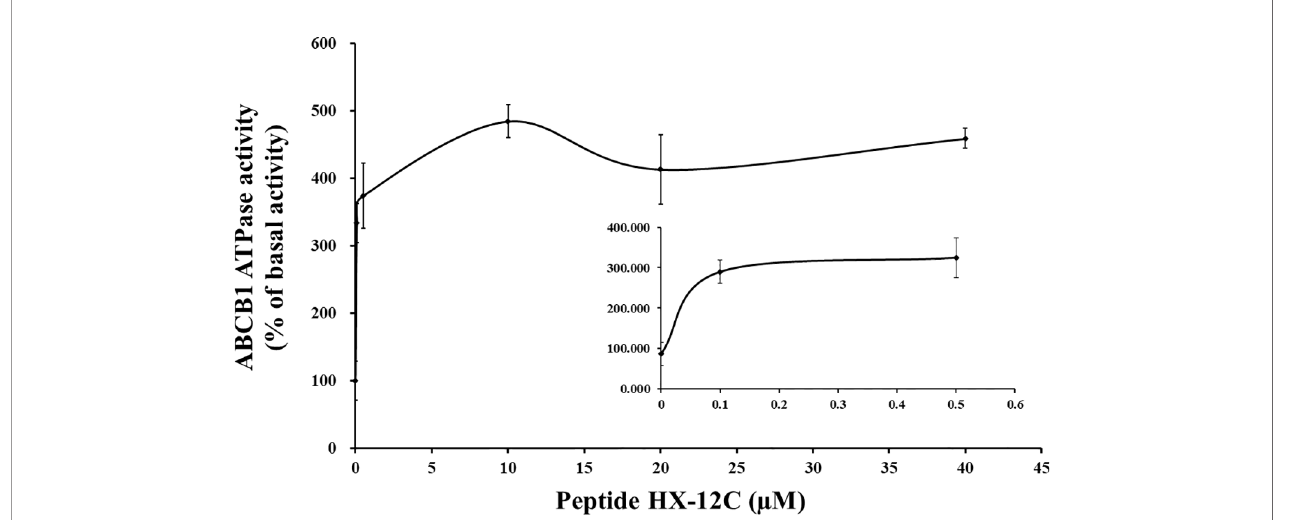
FIGURE 5 | Effect of peptide HX-12C on the ATPase activity of ABCB1. The sensitive ATPase activity of ABCB1 in insect cell membrane vesicles was determined in the presence of a series of different concentrations of peptide HX-12C. The small inner fi gure plotted the lower concentrations (0 – 0.5 m M) of peptide HX-12C versus ATPase activity. The points with error bars represent the mean ± SD from three independently repeated